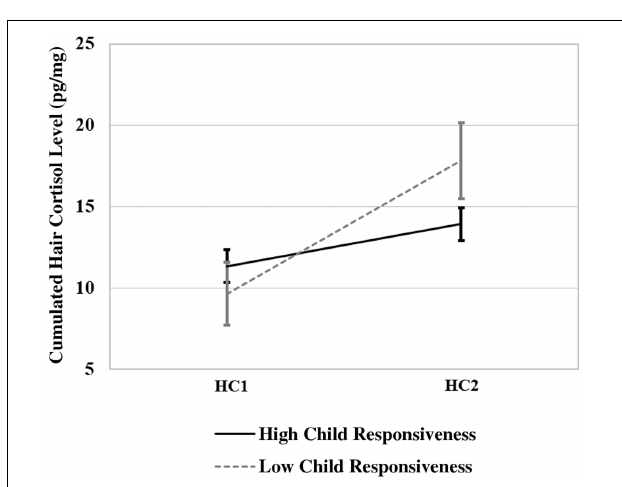
FIGURE 3 | Interaction between “change in cortisol level” (HC1 vs. HC2) and “child responsiveness” (high vs. low